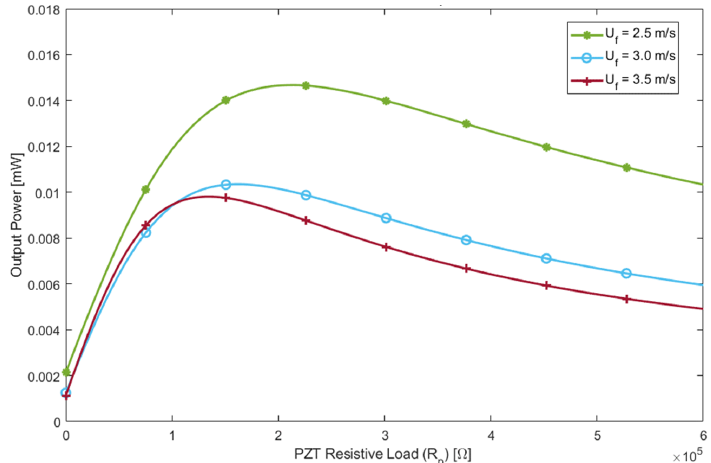
𝑅 (cid:3043) ) of the hybrid harvester at different